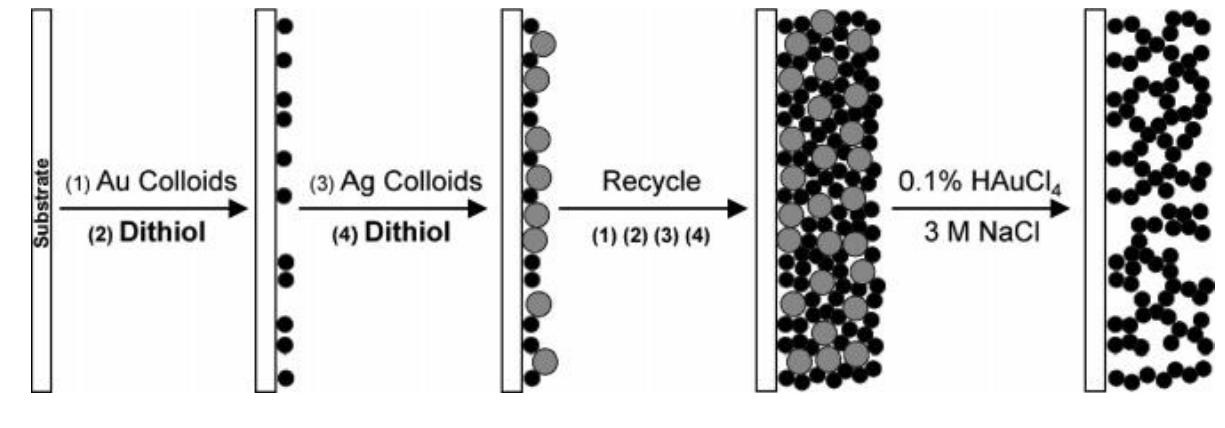
Figure 4. Schematic illustration of the preparation of multilayers of colloidal Au/Ag and the subsequent removal of colloidal Ag templates to form porous Au films. Reprinted with permission from [9]. Copyright 2005, American Chemical